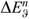
Eye and head contribution to gaze parameter distribution.Left panels: the azimuth eye (i.e. ΔEϑnblack bars) and head (i.e. ΔHϑnwhite bars) contributions to gaze are shown. For each subject data are averaged across the flight duration conditions (mean ± SE) and they are illustrated separately for the two different arrival heights conditions (top row: Z2, bottom row: Z1). Right panels: the same is illustrated relatively to the elevation coordinates (i.e. ΔEϕnandΔHϕn).